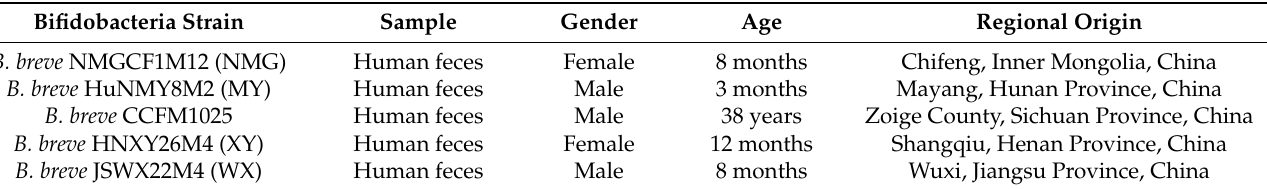
Table 1. Bifidobacteria strains used in this study. Bifidobacteria